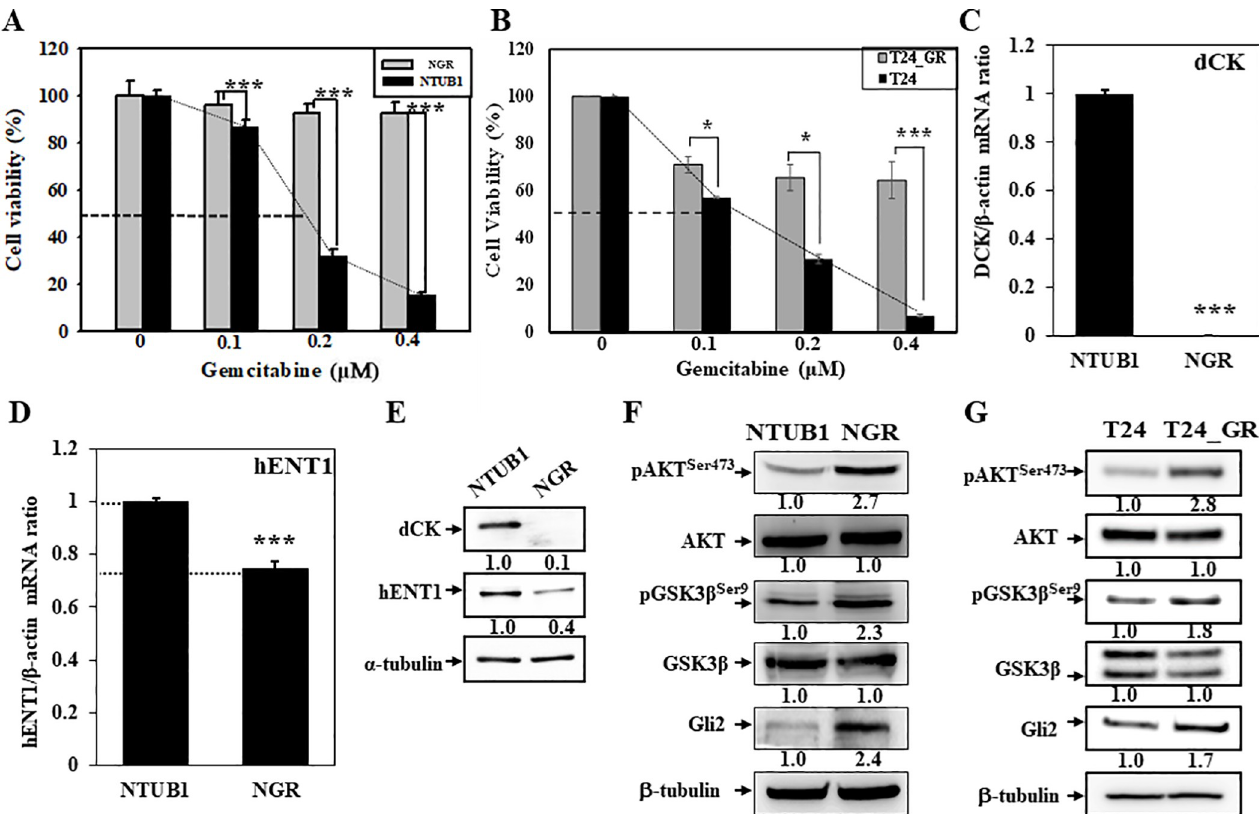
Fig 1. Increased phospho-AKT Ser473 , phospho-GSK3 β Ser9 and Gli2 proteins expression in NGR and T24_GR cells. (A) NTUB1/NGR and (B) T24/T24_GR cells were treated with various doses of gemcitabine (0 − 0.4 μ M) for 72 h, and were trypsinized and counted numbers by using a counting chamber to measure cellular viability. (C, D) Total RNA or (E-G) cell lysates were collected from NTUB1/NGR or T24/T24_GR cells to perform (C, D) quantitative real-time PCR or (E-G) Western blot, respectively. Gemcitabine resistance-related genes dCK and hENT1 were measured at (C, D) mRNA or (E) protein levels, respectively. Protein expression of phopho-AKT ser473 , phospho-GSK3 β ser9 and Gli2 was also detected in (F) NTUB1/NGR and (G) T24/T24_GR cells, respectively.